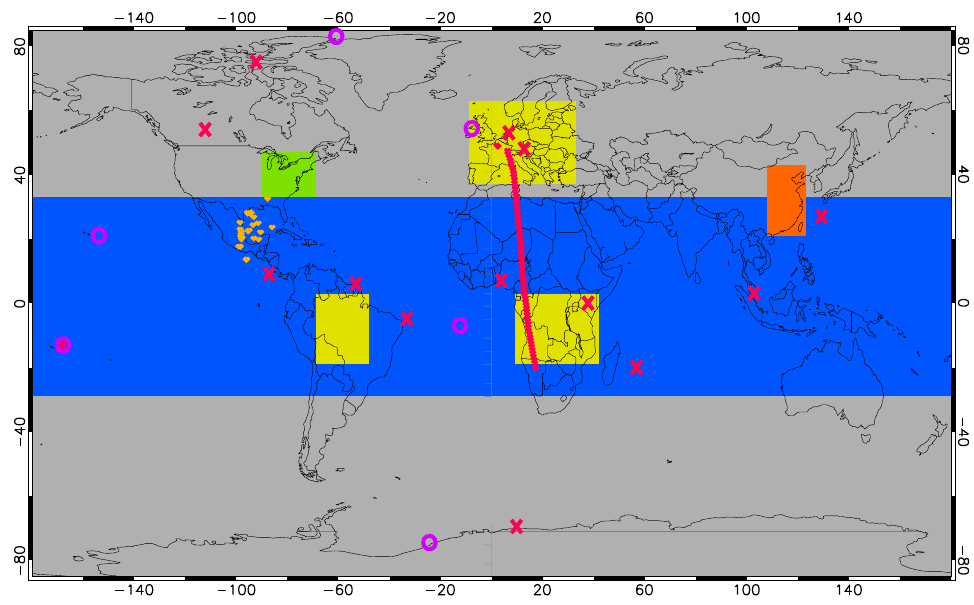
Fig. 1. The various regions, stations and flight locations used in the evaluation. The definition of these regions is as follows: trop- ics (30 ◦ S–30 ◦ N), Eastern United States (90 ◦ W–71 ◦ W × 31 ◦ N–43 ◦ N), Europe (10 ◦ W–30 ◦ E × 35 ◦ N–60 ◦ N), Eastern China (108 ◦ W– 120 ◦ W × 20 ◦ N–40 ◦ N), Central Africa (10 ◦ E–40 ◦ E × 20 ◦ S–0 ◦ N), South America (70 ◦ W–50 ◦ W × 20 ◦ S–0 ◦ N). The pink circles indi- cate the GMD stations used for the evaluation of surface O 3 and CO, and the red crosses indicate the WOUDC stations used for the evaluation of O 3 profiles. The red line denotes the flight path of the aircraft used for the comparison against MOZAIC data. Yellow dots indicate the ascents and descents from the INTEX-B campaign used in the NO 2 evaluation.